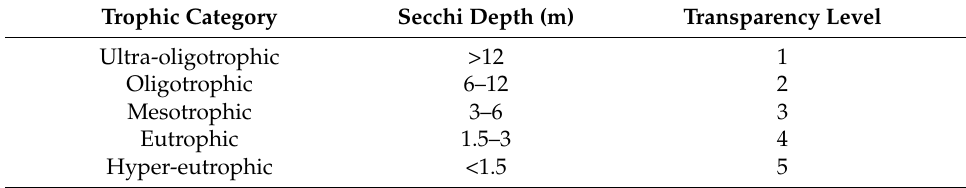
Table 3. Transparency level definition according to thresholds of SD values